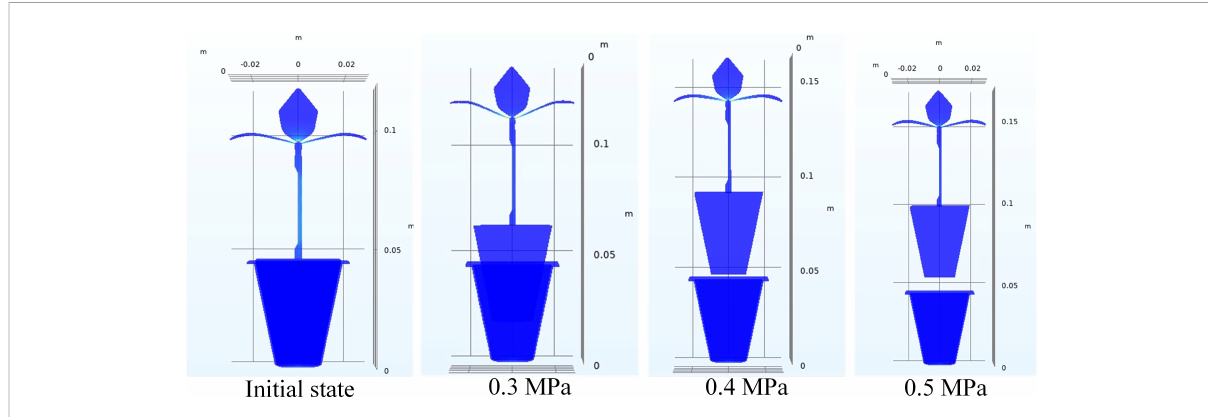
FIGURE 7 Effect of seedling ejecting under different air fl ow